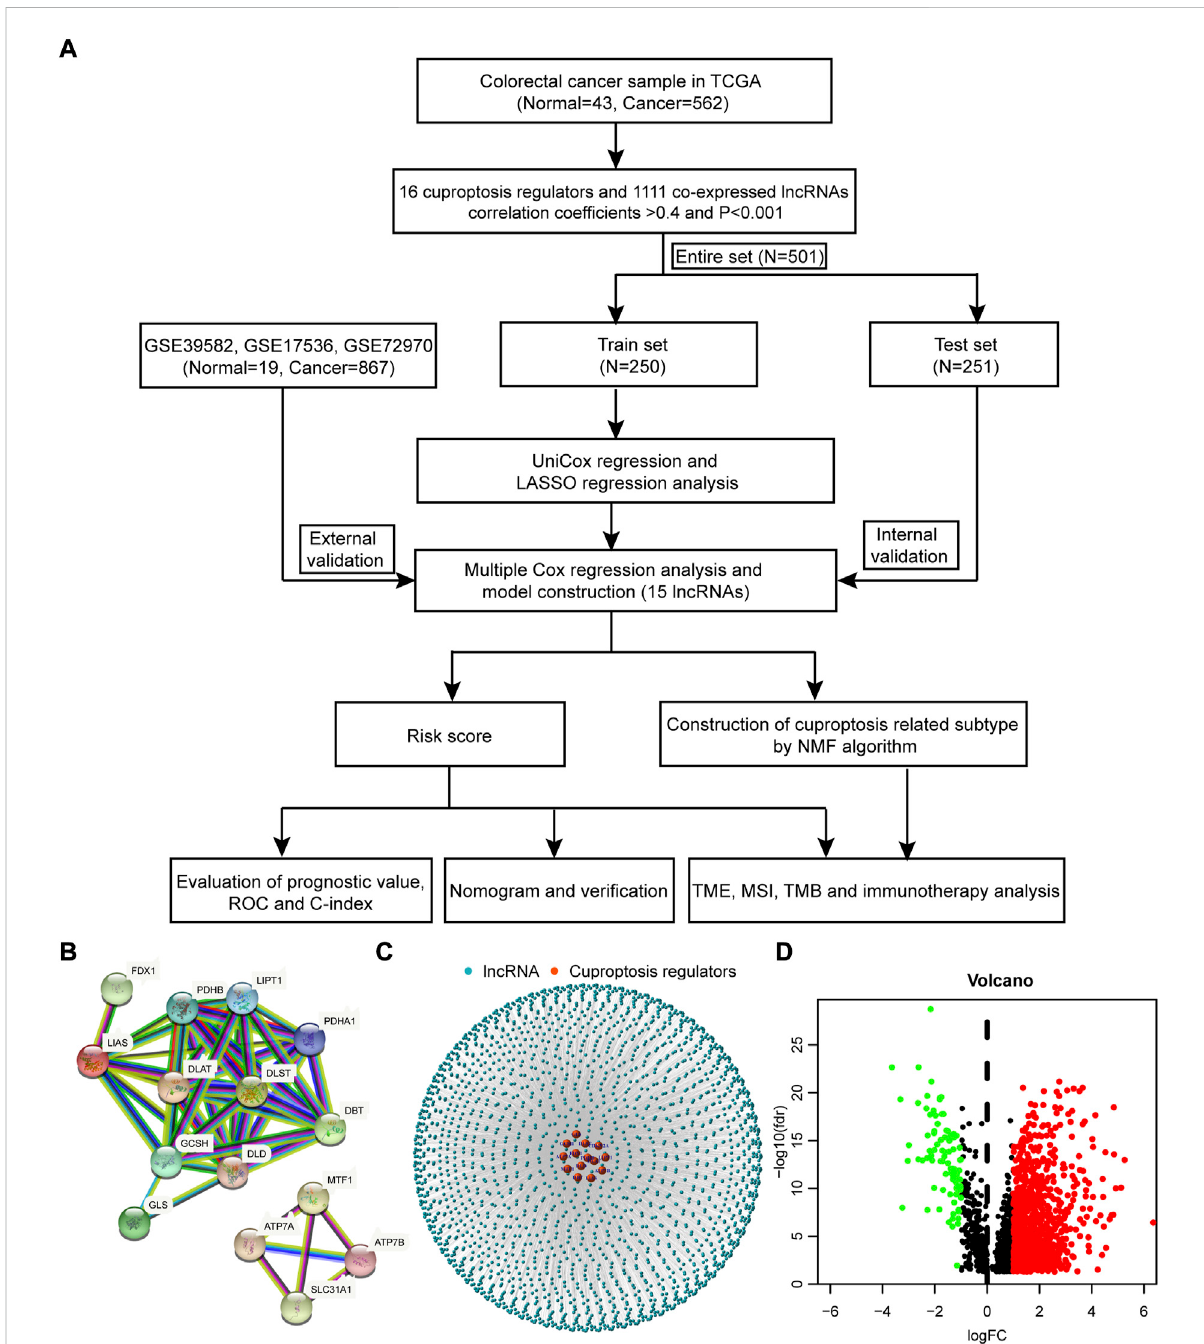
FIGURE 1 The process of this work and network of lnRNA-mRNA co-expression. (A) The process of this work. (B) The PPI network of 16 cuproptosis regulatorsanalyzedbytheSTRINGdatabase. (C) ThelncRNA-mRNAco-expressionnetwork. (D) ThevolcanoplotofdifferentiallyexpressedlncRNAs between normal and cancer